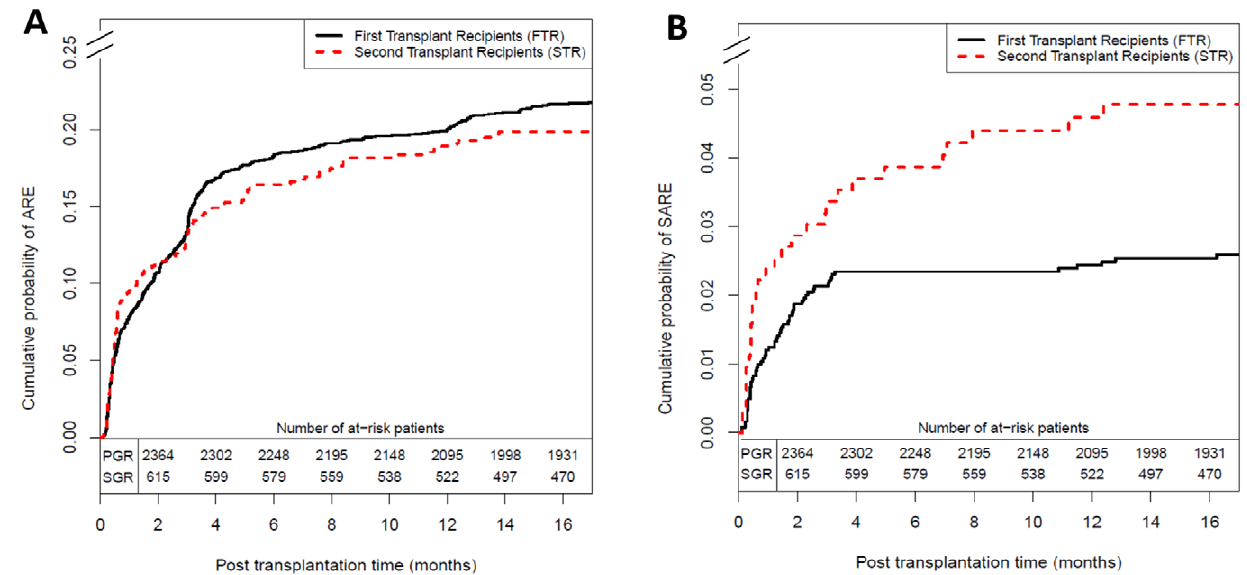
Figure 2. Cumulative probability of acute rejection episodes. ( A ) Cumulative probability of acute rejection episodes for FTR and STR (log-rank test: p=0.4420) and ( B ) Cumulative probability of severe acute rejection episodes for FTR and STR (log-rank test: p=0.0040), for first and second